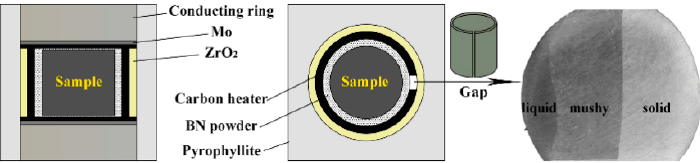
Figure 1. Schematic illustration of the assembly sample in the high-pressure solidification process, the structure of the graphite heater, and the final macrostructure.